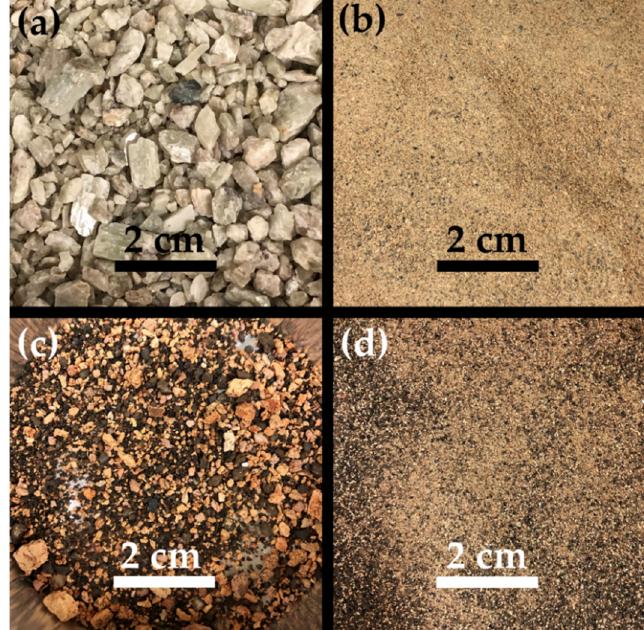
Figure 2. Converted concentrate after thermal treatment: ( a ) initial material, ( b ) under 425 µm, ( c ) over 425 µm, and ( d ) sample A (finer fraction {(b)} + ground coarser fraction {(c)}).